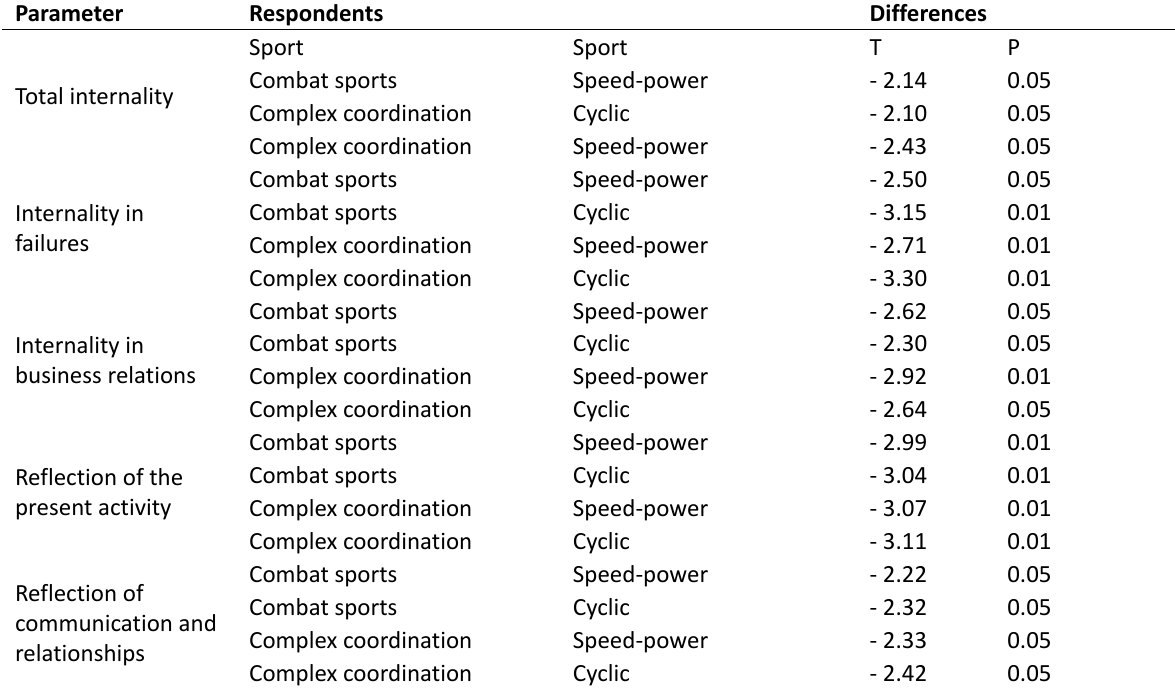
Table 5. Statistically significant differences in the development level of personal qualities among athletes of different